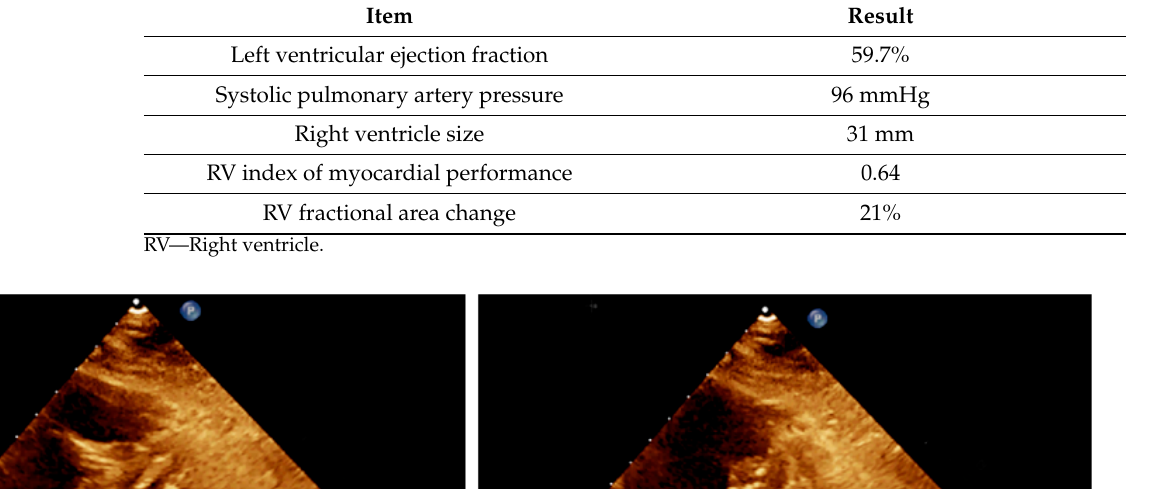
Table 2. Echocardiographic results.